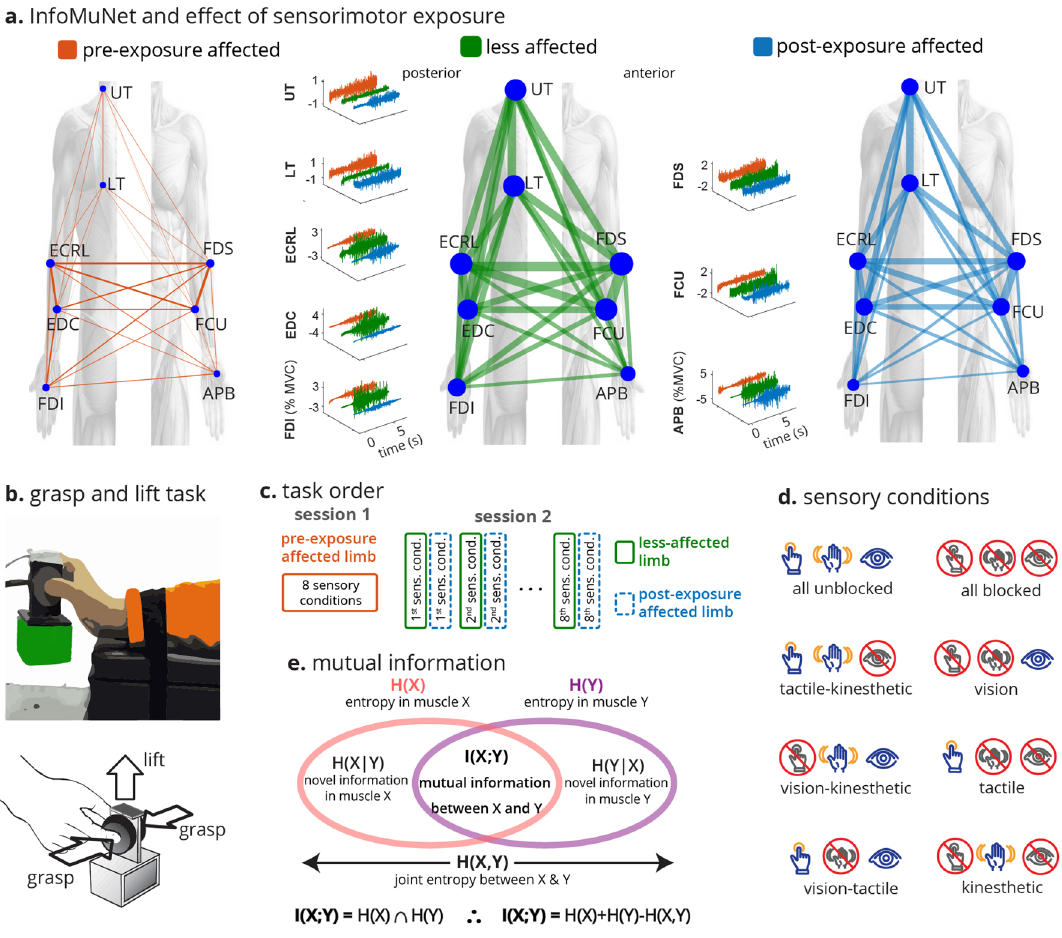
Figure 1. Grasp-and-lift task and InfoMuNet overview. ( a ) Electromyographic signals were recorded from eight muscles on each limb: Abductor Pollicis Brevis (APB), First Dorsal Interosseous (FDI), Flexor Digitorum Superficialis (FDS), Extensor Digitorum Communis (EDC), Flexor Carpi Ulnaris (FCU), Extensor Carpi Radialis Longus (ECRL), Upper Trapezius (UT), and Lower Trapezius (LT). The median InfoMuNet